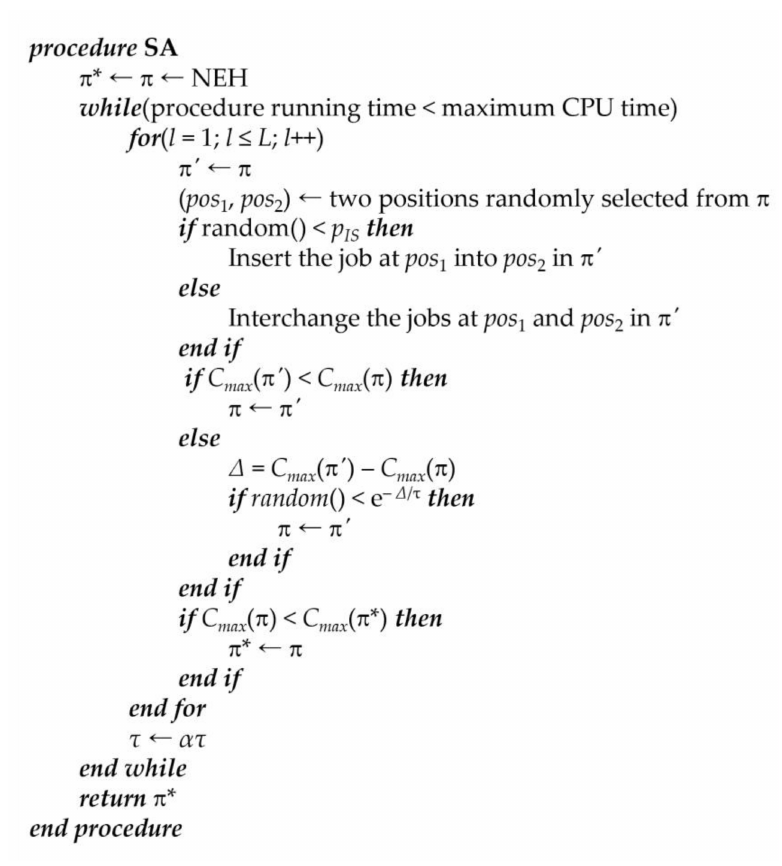
Figure 5. Proposed simulated annealing algorithm